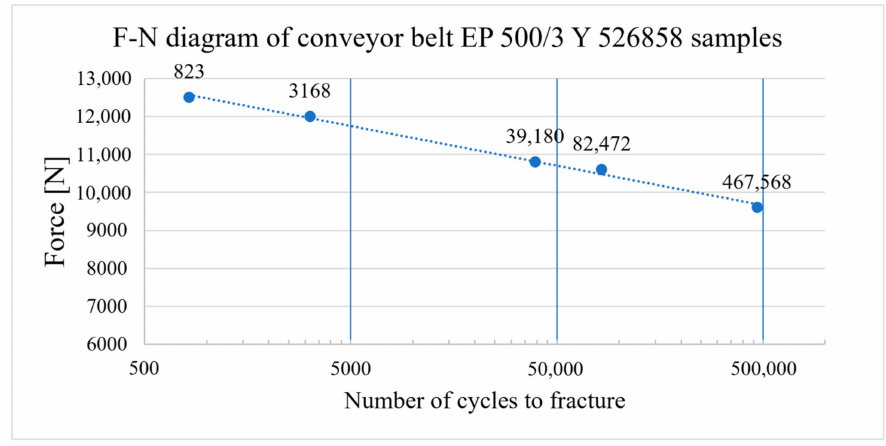
Figure 8. Graphically presented results and F-N curve.